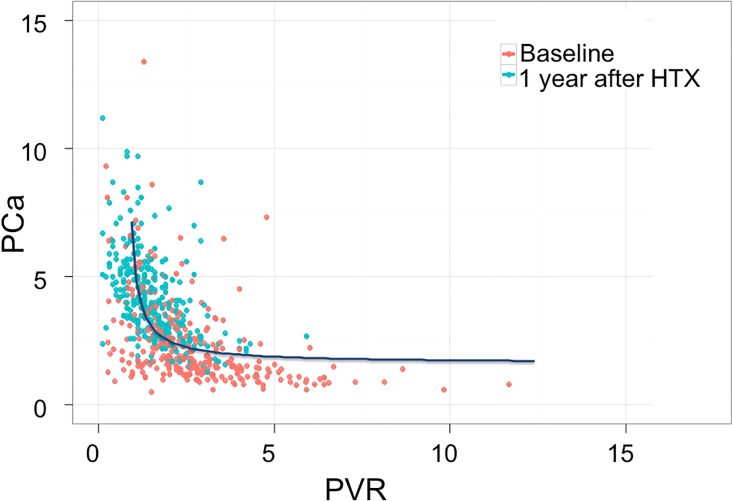
PCa vs. PVR data at baseline and after transplant in the entire cohort.Red dots indicate baseline values, green dots data at 1 month and blue dots data at 1 year after transplant.